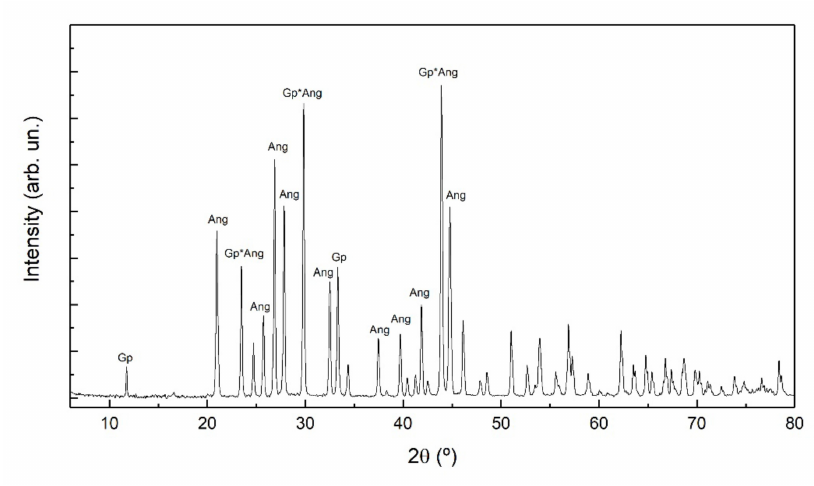
Figure 5. X-ray powder diffraction pattern of gypsum crystal interacting with a Pb-bearing solutions. All diffraction peaks can be assigned to gypsum (Gp) and anglesite (Ang). The sign “*” indicates that one reflection can be asigned to both gypsum (Gp) or Anglesite (Ang).